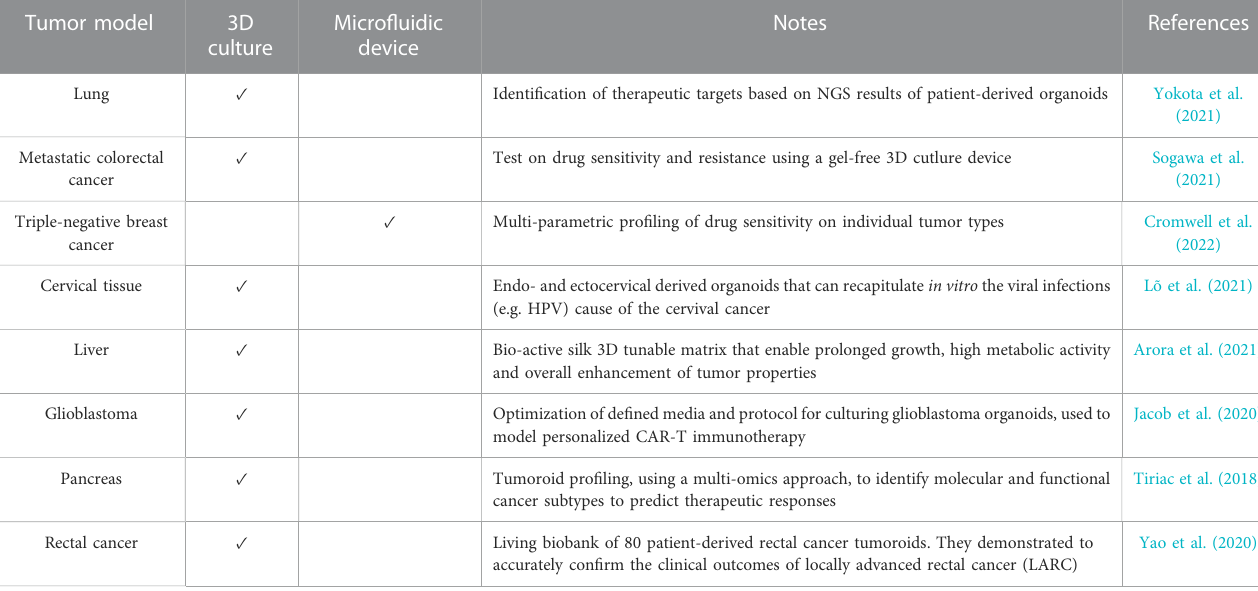
TABLE 2 Overview of the major advances and applications in patient-derived